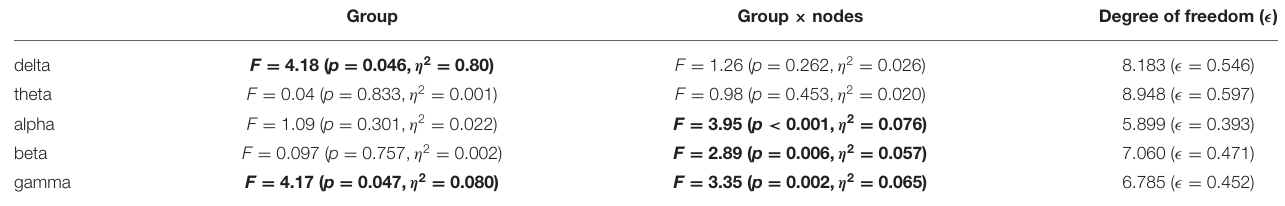
TABLE 3 | Younger vs. older repeated-measure ANOVA analysis results [ F value ( p value, partial η 2 )] in the node strength (NS) of phase lag index (PLI). Group